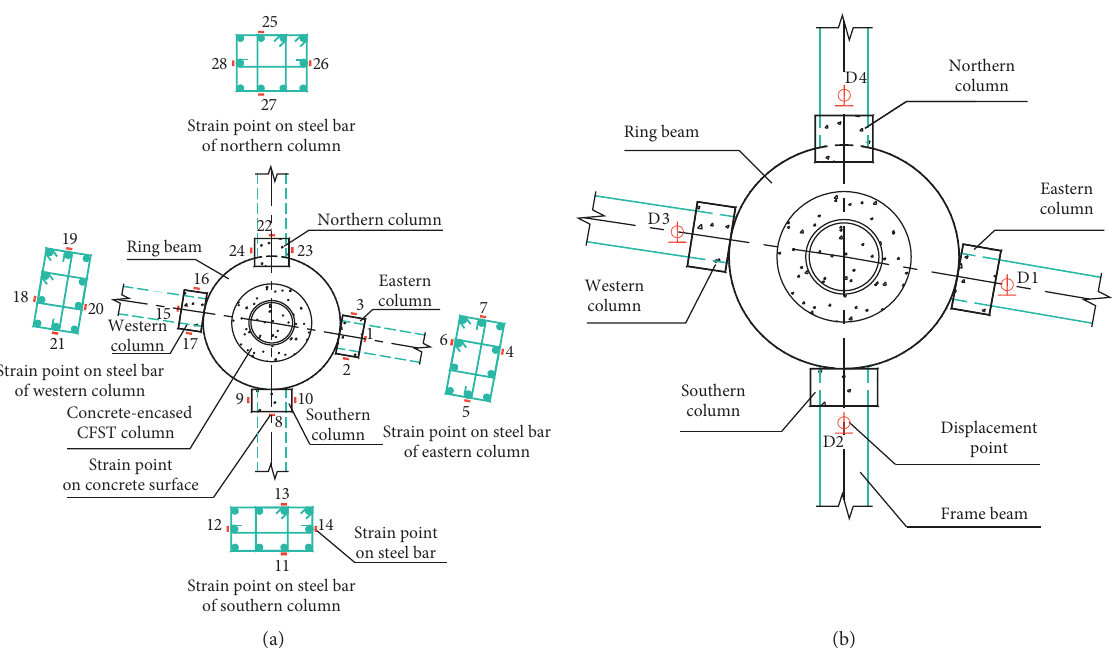
Figure 6: Strain points of the support columns and the displacement points of beam ends. (a) Arrangement of strain measuring points; (b) arrangement of displacement measuring points.